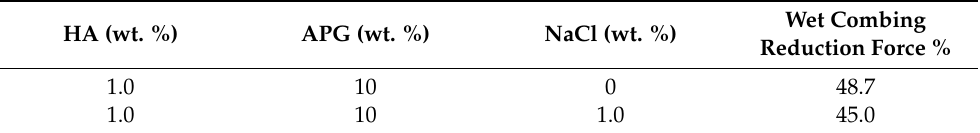
Table 6. Effect of HA Concentration with APG on Wet Combing Reduction Force.